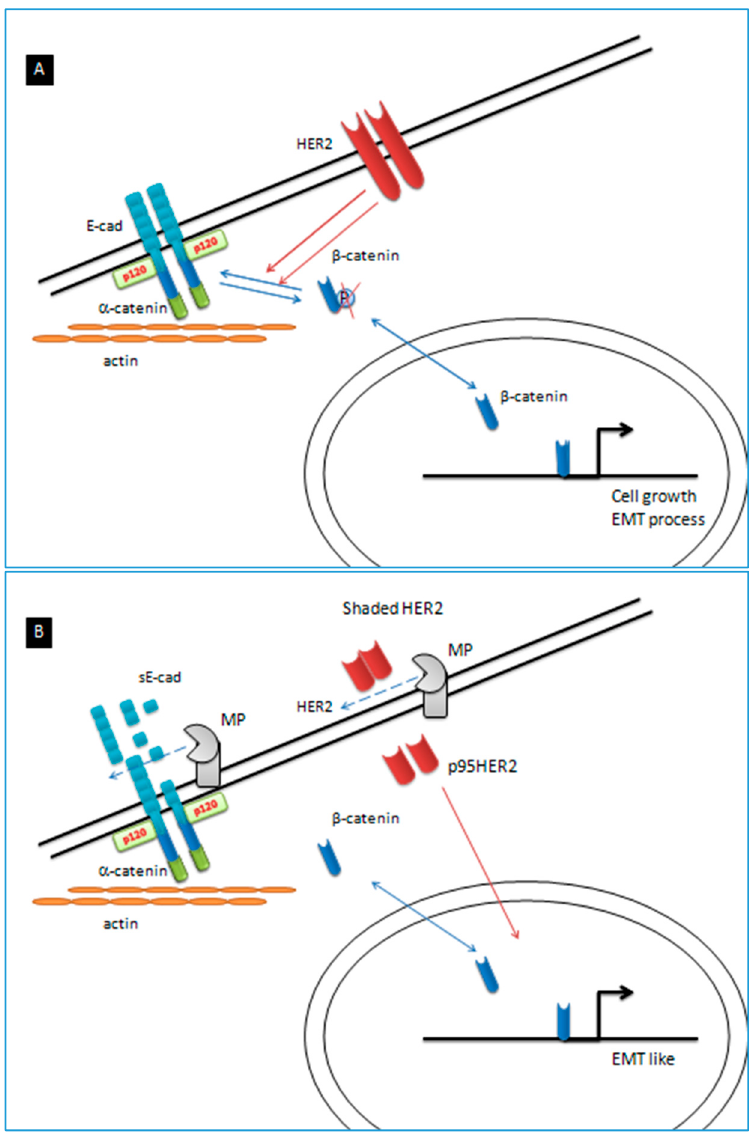
Figure 1. Schematic diagram of E-cadherin- HER2 interaction. The E-cadherin present three different domains: the conserved cytoplasmic domain, a transmembrane domain, and an extracellular domain. The E-cadherin cytoplasmic tail presents two regions: the catenin-binding domain and the juxtamembrane domain. β -catenin binds to the E-cadherin domain and this complex via α -catenin connects and regulates E-cad interaction with the actin cytoskeleton. p120-catenin binds the CDH1 juxtamembrane domain and stabilizes E-cad expression at the cell surface. ( A ) Activation of the HER2 by inducing the phosphorylation of β -catenin directs the dissociation of β -catenin from the E-cad complex, thus leading to a decrease of E-cad-mediated cell adhesion, facilitate epithelial-mesenchymal transition (EMT), and the translocation of β -catenin to the nucleus where it acts as a transcriptional regulator of genes involved in cell growth and the EMT process; ( B ) HER2 activation increases metalloproteinase (MP) activity, which leads to an increased production of soluble E-cadherin (sE-cad) through the cleavage of E-cad. Metalloproteinase also cleaves HER2 into a cytoplasmic tail domain, p95 HER2 , and a shaded soluble HER2 fragment. The p95 HER2 fragment maintains the phosphokinase activity, thus favoring the dissociation of the β -catenin/E-cad complex leading to GC progression and metastasis. The production of the sE-cad causes a reduction in cell adhesion and, by its diffusion into the microenvironment, acts as a paracrine/autocrine signaling molecule that regulates numerous signaling pathways implicated in tumor progression, including a key role in the HER2 interaction/activation and phosphorylation of β -catenin.